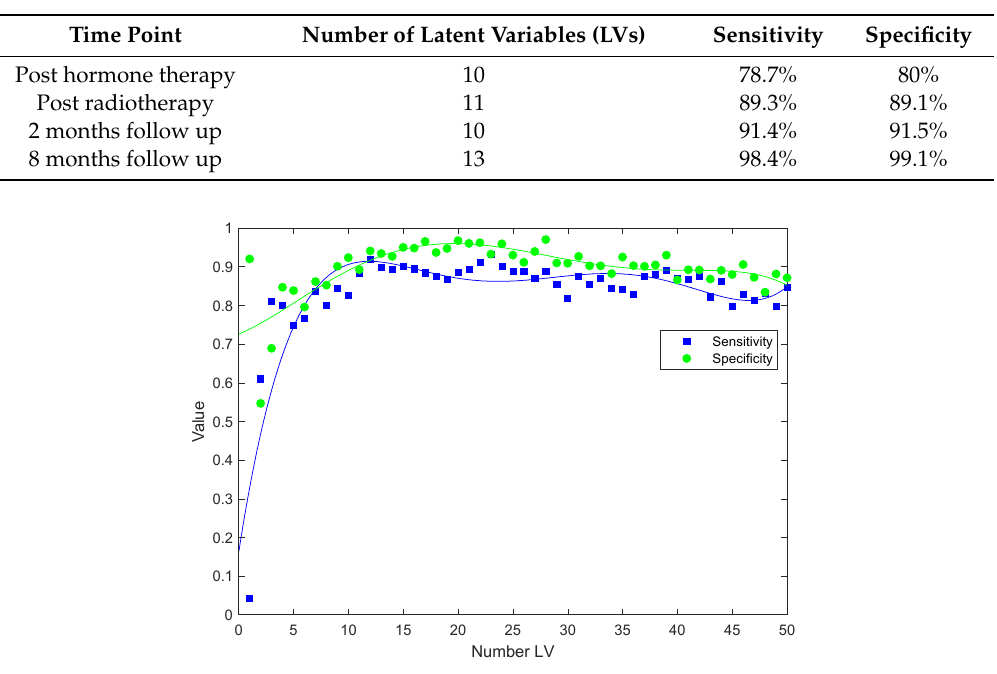
Table 1. Sensitivities and specificities for the PLS-DA classification of patients at baseline versus different treatment stages.